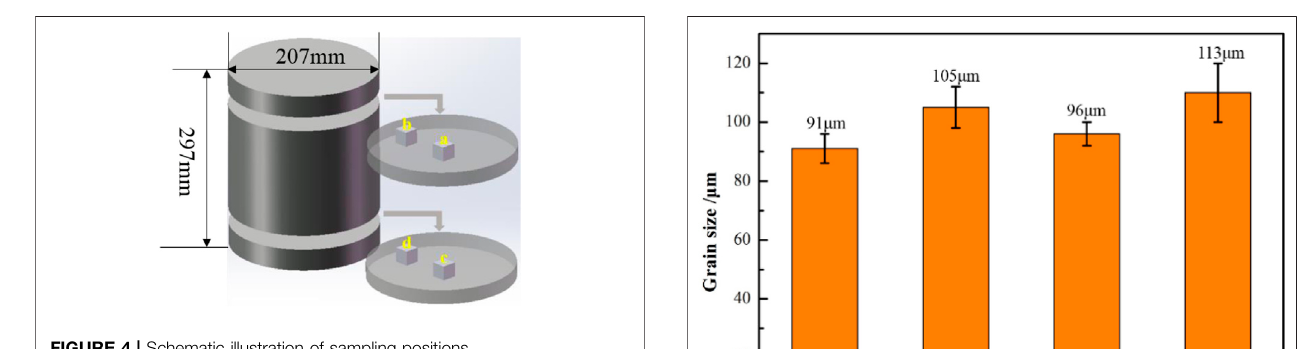
FIGURE 4 | Schematic illustration of sampling positions.